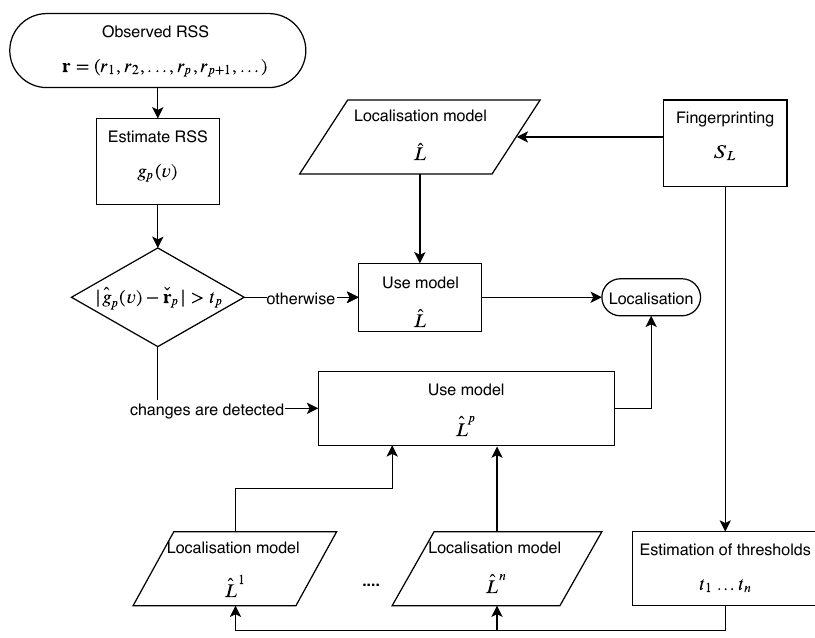
Figure 1. Localisation schema using the characteristics changes detection Indoor Positioning System. The threshold belongs to a set of unique error values E calculated on the learning data set S AP